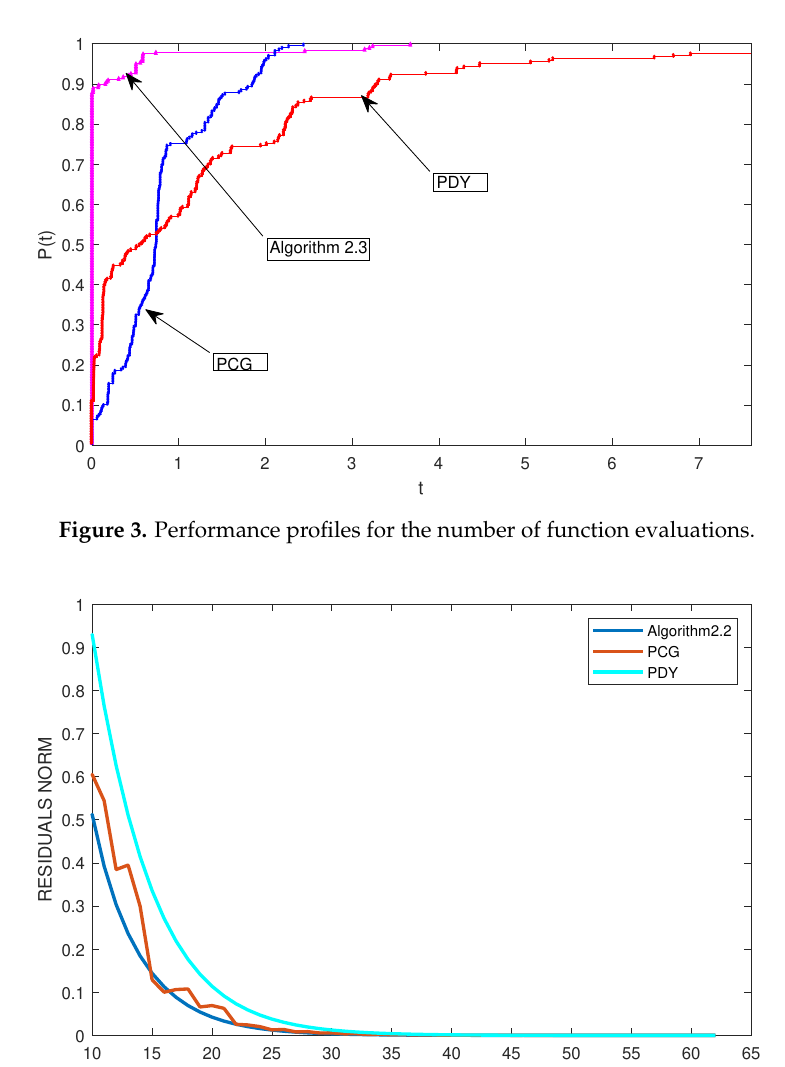
Figure 2. Performance profiles for the CPU time (in seconds).